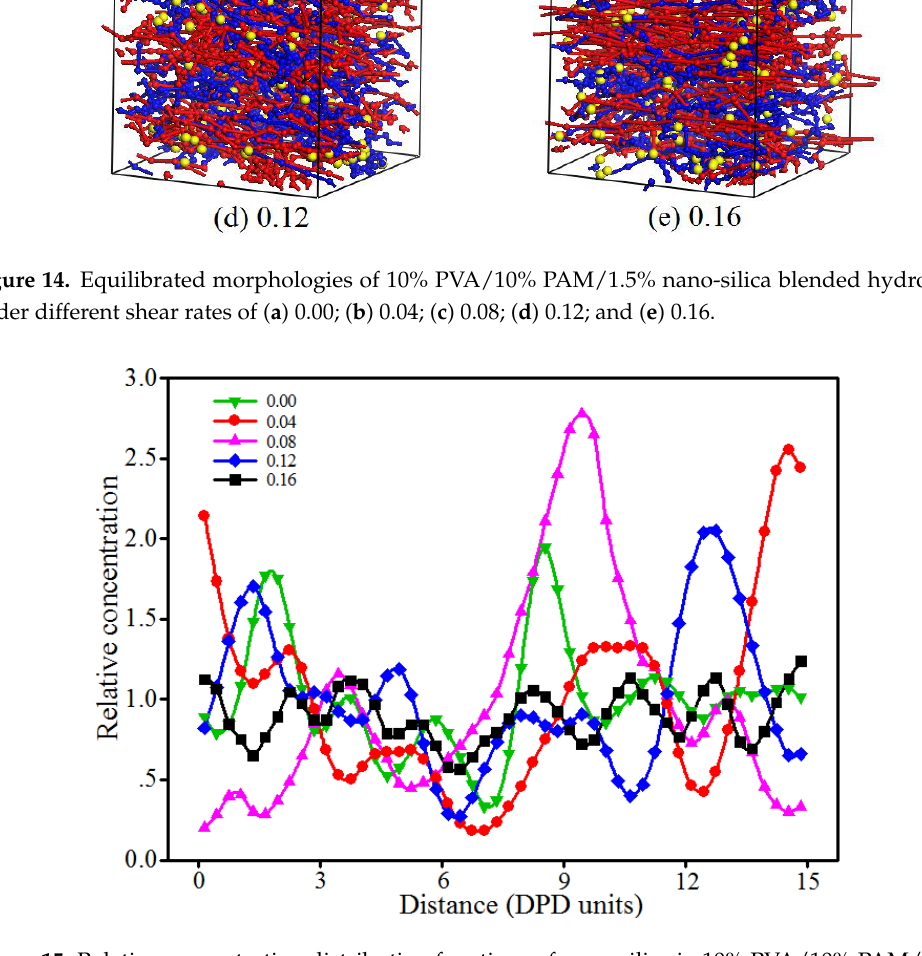
Figure 16. Concentration profile maps of PAM and PVA in 10% PVA/10% PAM/1.5% nano-silica blended hydrogels in the YZ plane with shear rates of ( a ) 0.00 and ( b ) 0.16.